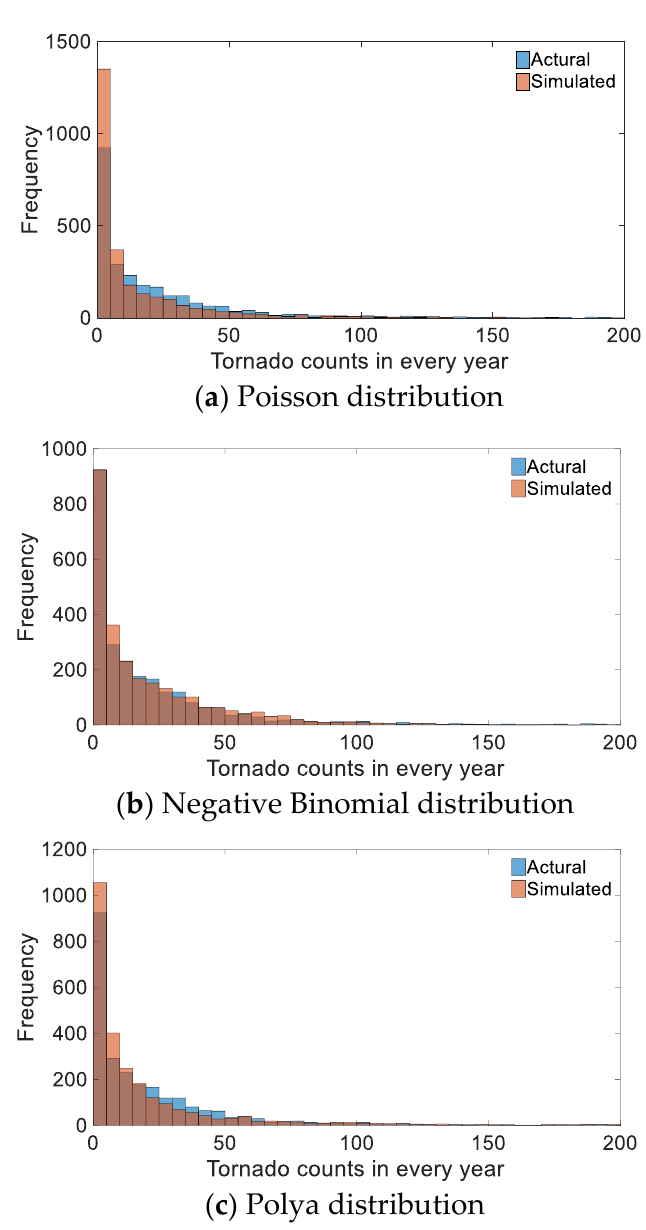
Figure 4. Histogram of simulated and real values for three different distributions.